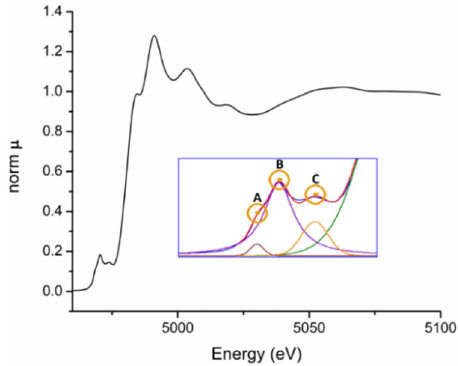
Figure 24. Normalized XANES spectrum of the Ti K edge of a BNBT4 powder sample, recorded at Stanford Synchrotron Radiation Lightsource. The inset corresponds to A, B and C modeled Lorentzian peaks of the pre ‐ edge of XANES zone. Table 3. XANES results for BNBT100 x .